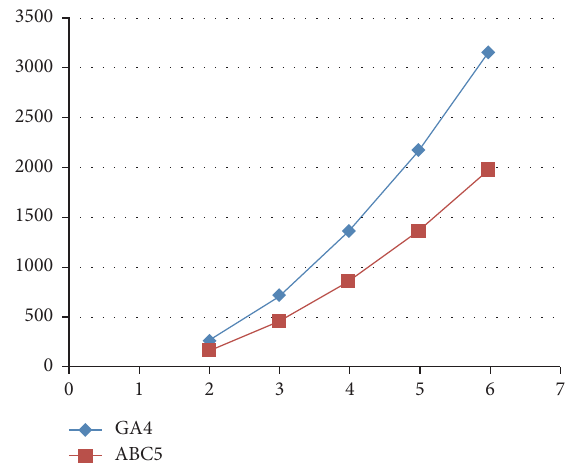
Figure 2: Comparison of GA Table 3: Comparison of GA